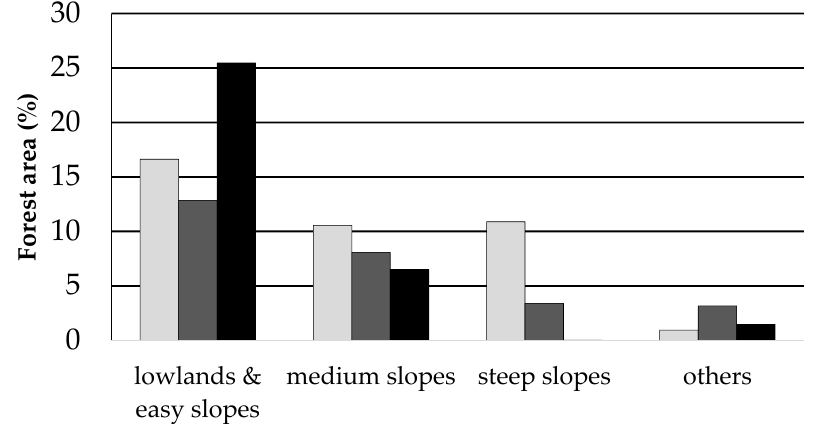
Figure 5. Distribution of the analyzed forest area with regard to topography and soil sensitivity to traffic (light grey: insensitive, dark grey: partly sensitive and black: sensitive), as a percentage of total forest